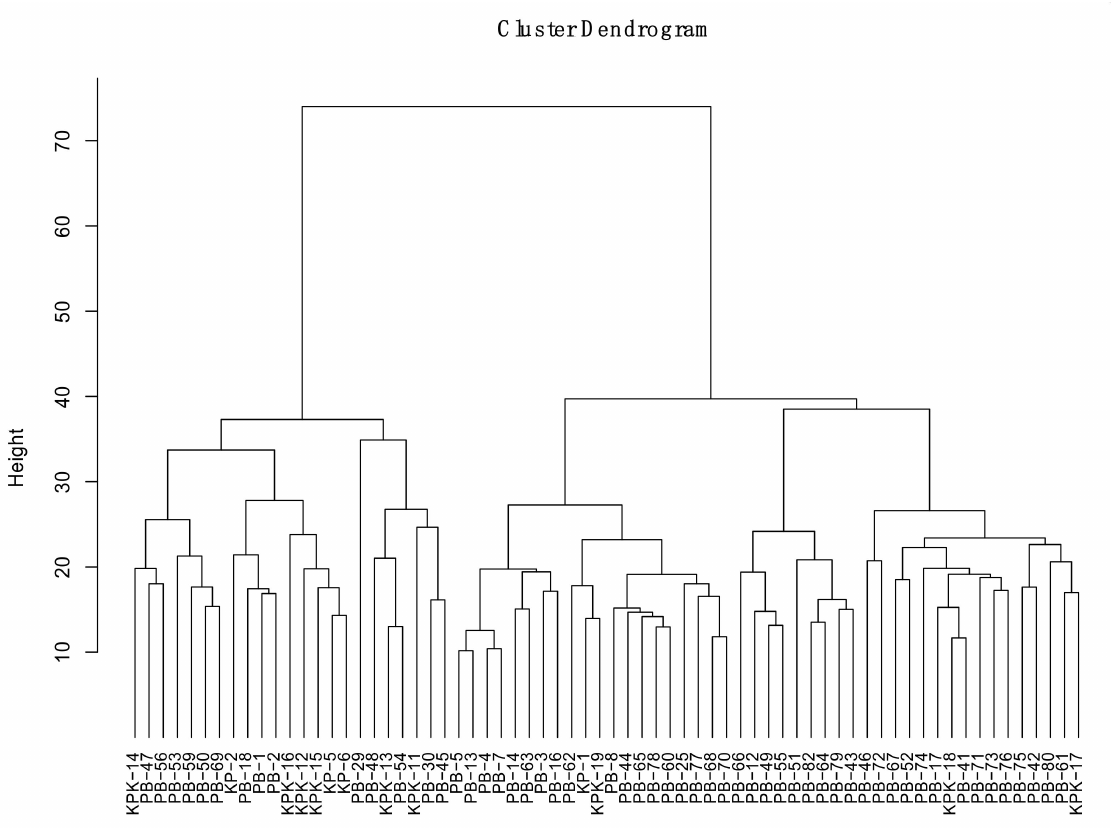
Figure 5. Dendrogram constructed by using UPGMA based on the Euclidean coefficient of combined RAPD–ISSR for 68 T. indica